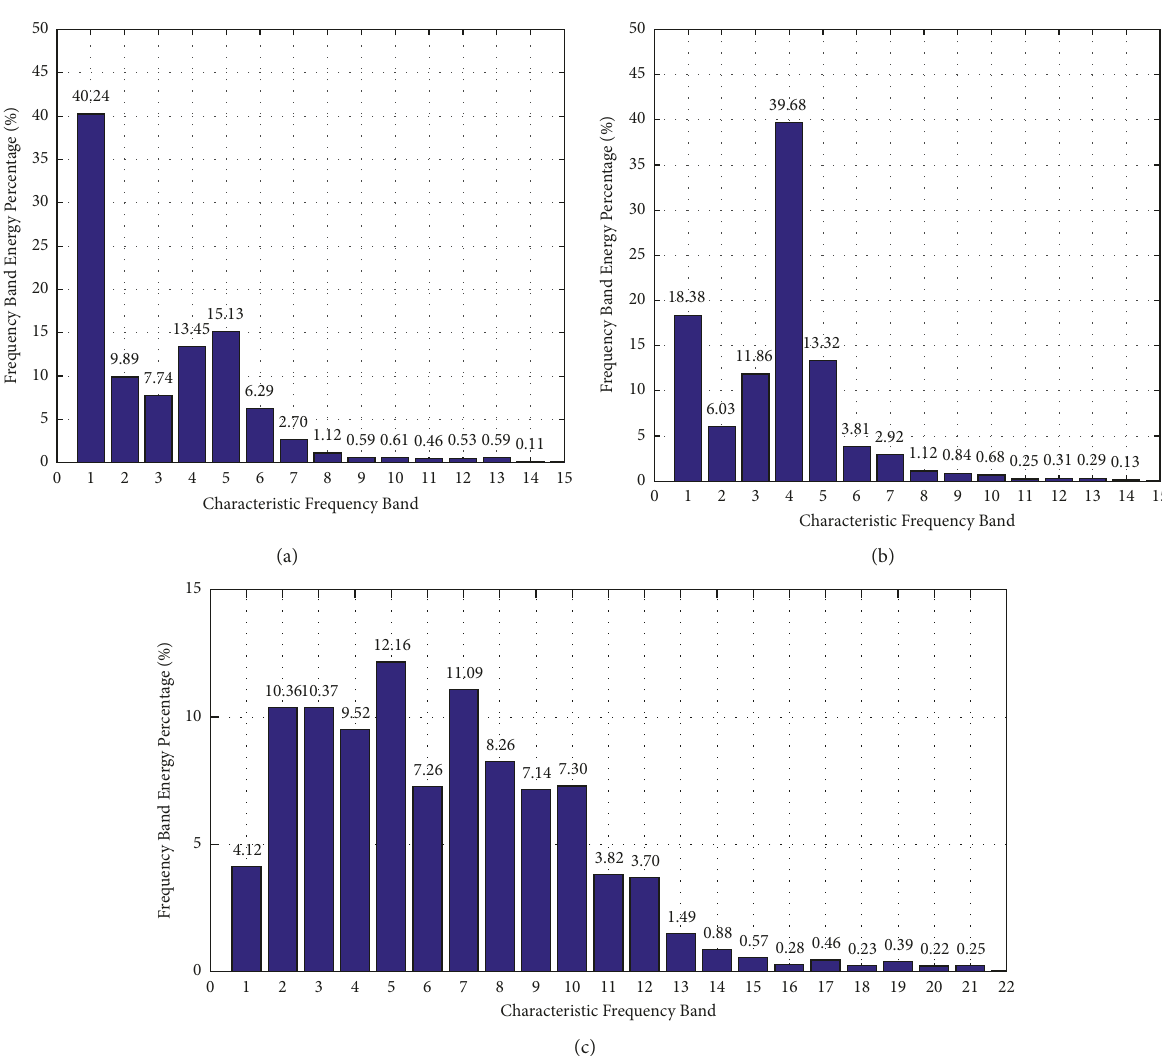
Figure 2: Energy probability distribution of earthquake records at 53YBX (8.6km from the epicentre): (a) east-west; (b) north-south; (c) and